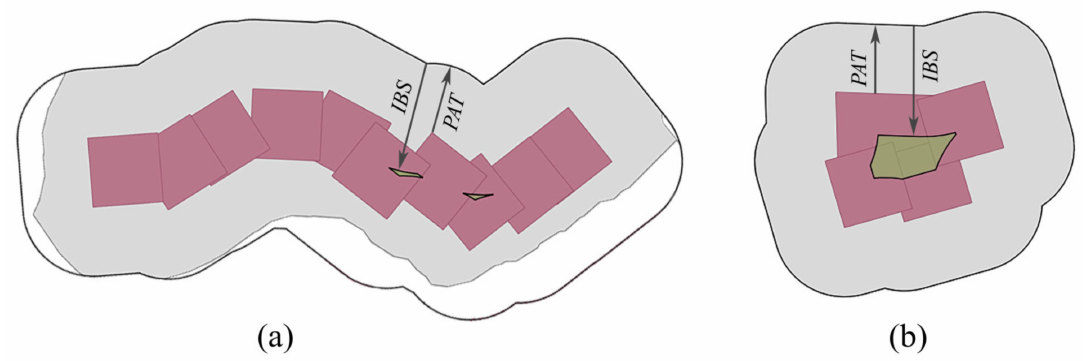
Figure 3. Detection of the zones with linear patterns decided by the size of final polygon (light green). A linear pattern is ( a ) found, ( b ) not